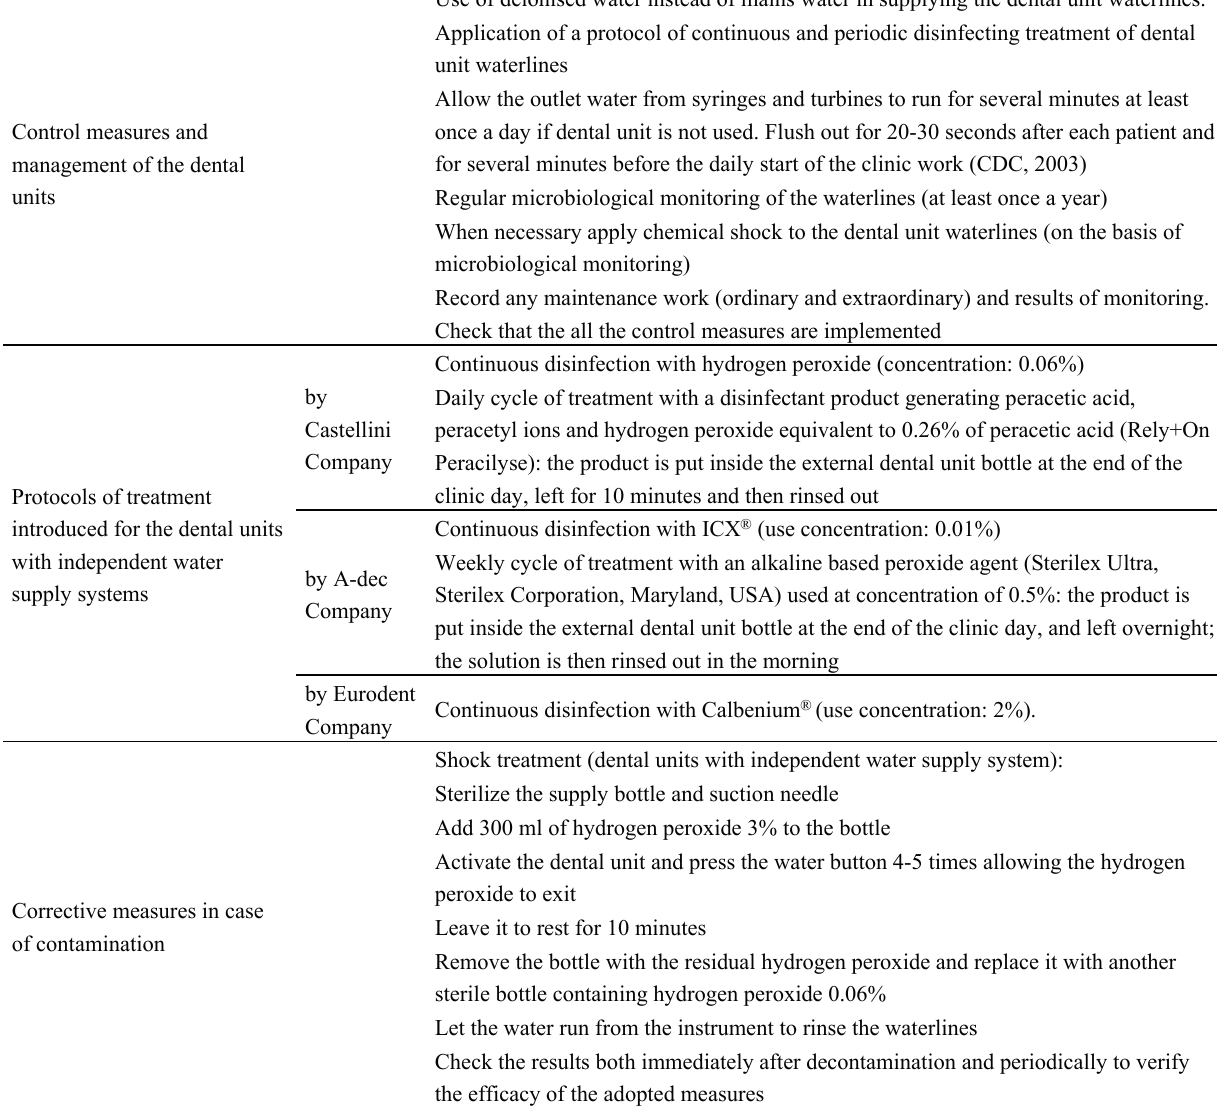
Table 3. Preventive and corrective measures implemented in the internal quality plan for the control of Legionella contamination in the dental health care